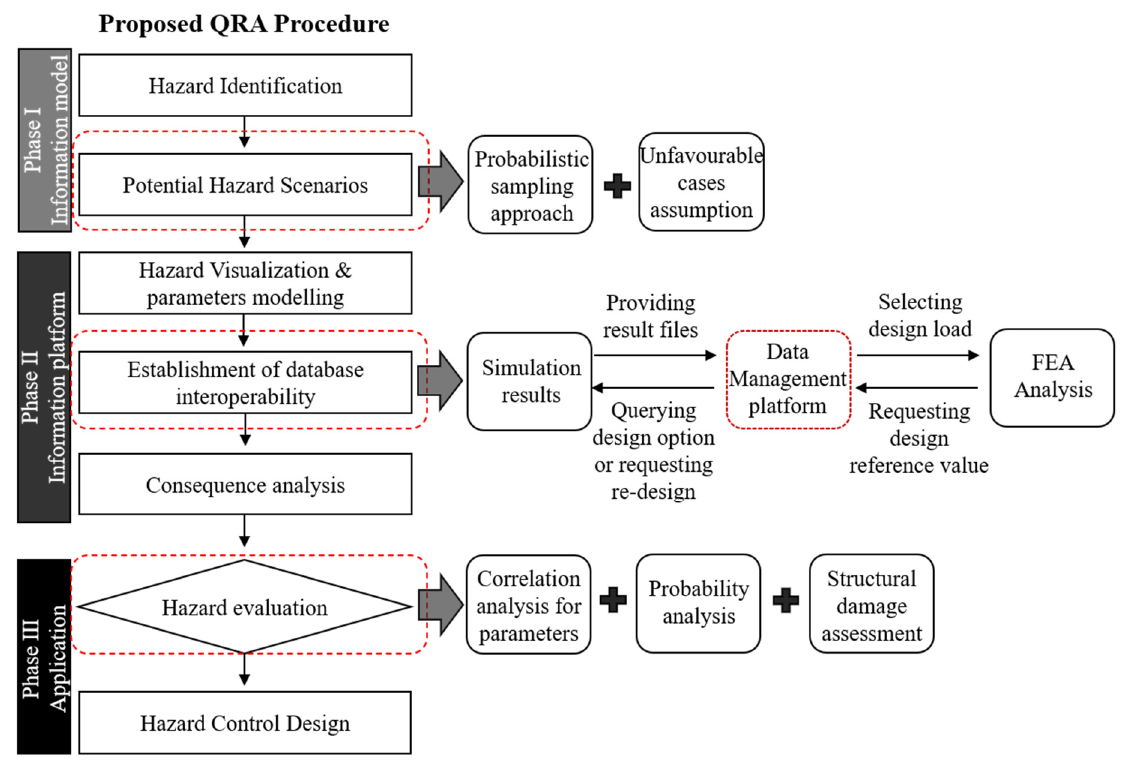
Figure 7. The framework of the proposed hazard assessment using BIM and CFD integration.